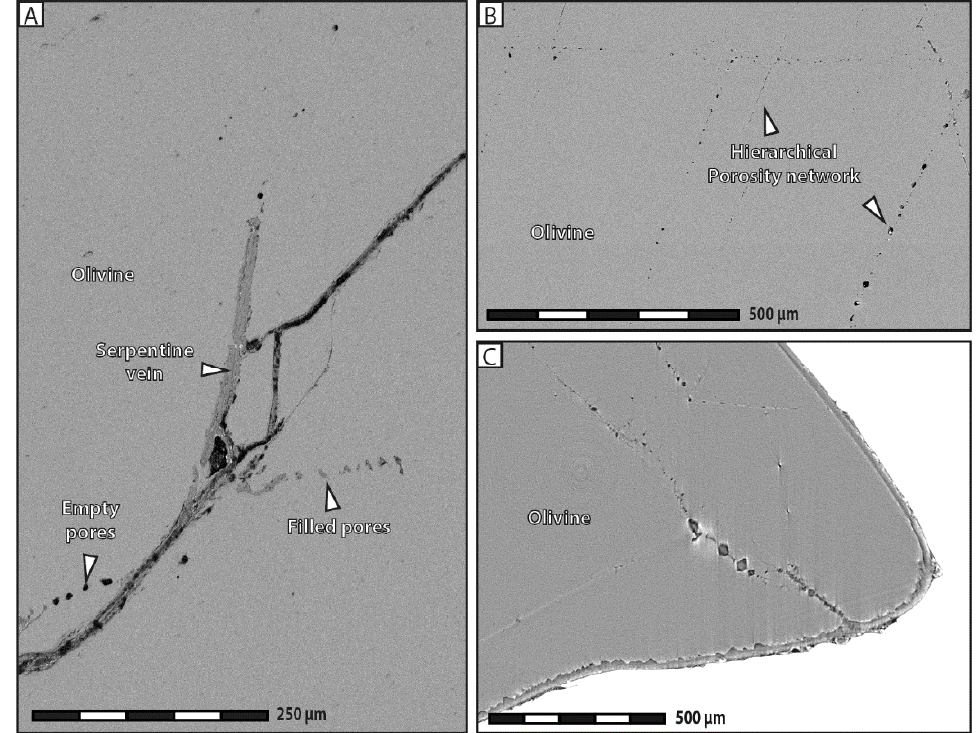
Figure 6. Porosity after reaction in NaOH solution. ( A ) BSE image of empty and filled pore trails closely related to a serpentine vein. ( B ) BSE image of the hierarchical porosity network formed by pores of different sizes growing up along microcracks ( C ) Phase-contrast X-ray synchrotron microtomography image showing tiny spherical pores lining up with large diamond-shaped pores. ( A ) is for t = 6 months (run # 2), and ( B , C ) for t = 12 months (run # 3).